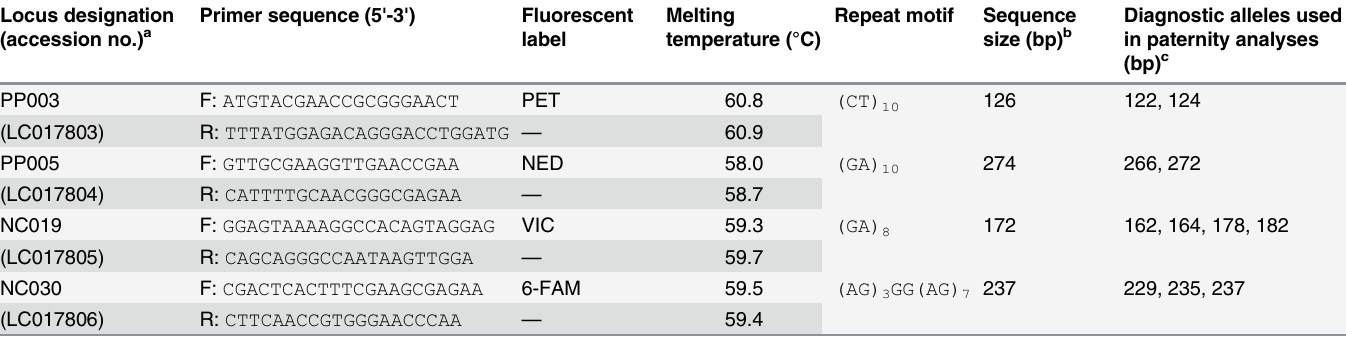
Table 1. Primer sequences and characteristics of four polymorphic microsatellite loci in the predatory mites P . persimilis (PP003 and PP005) and N . californicus (NC019 and NC030). Primer sequence Locus designation (accession no.) a